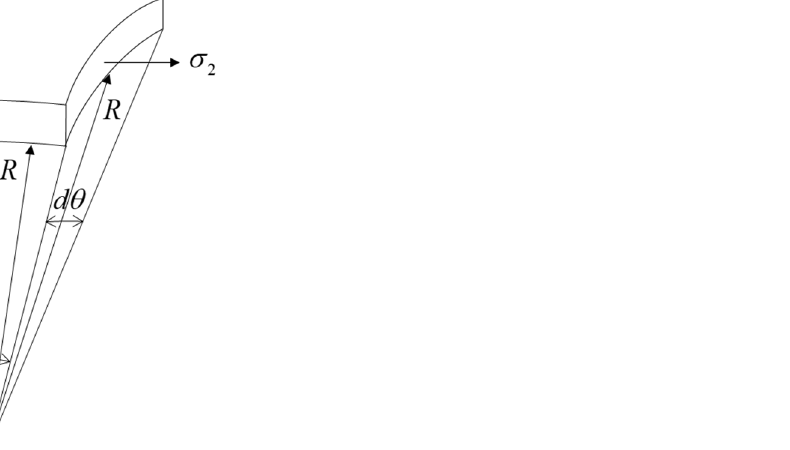
Figure 1. Stress at an infinitesimal apex element in a single metal layer.